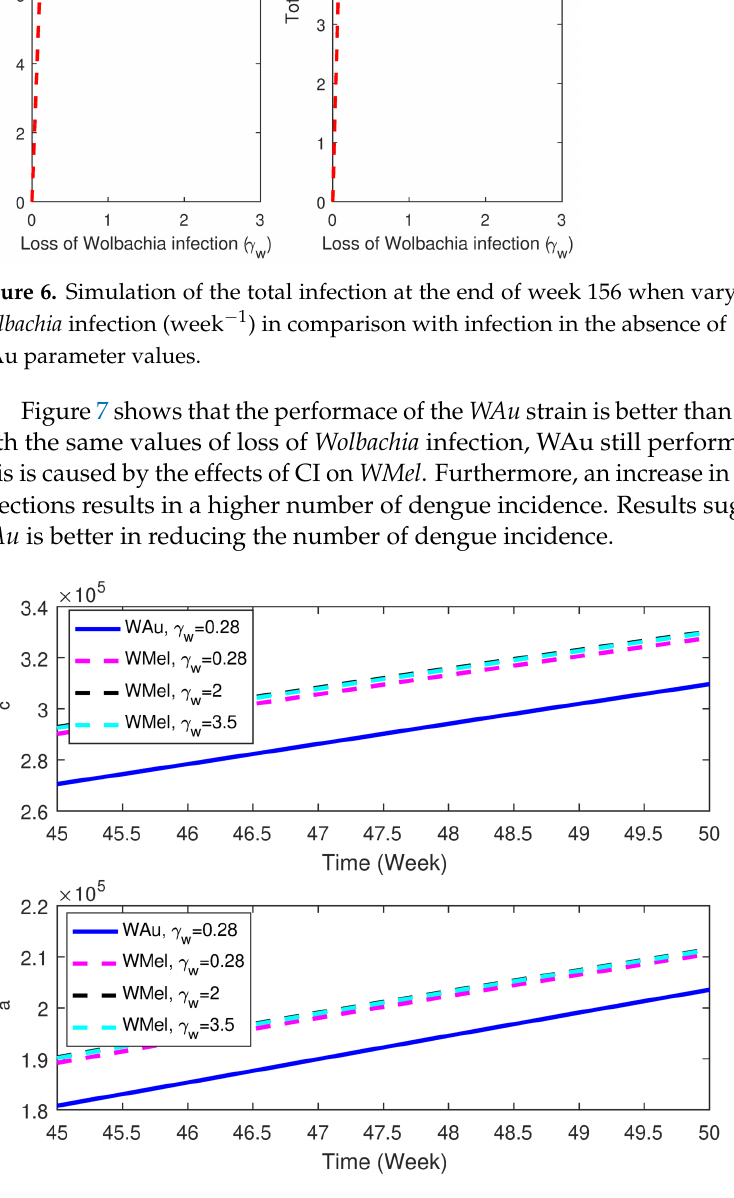
Figure 7. Simulation of infected individuals in the presence of different Wolbachia strain and absence of